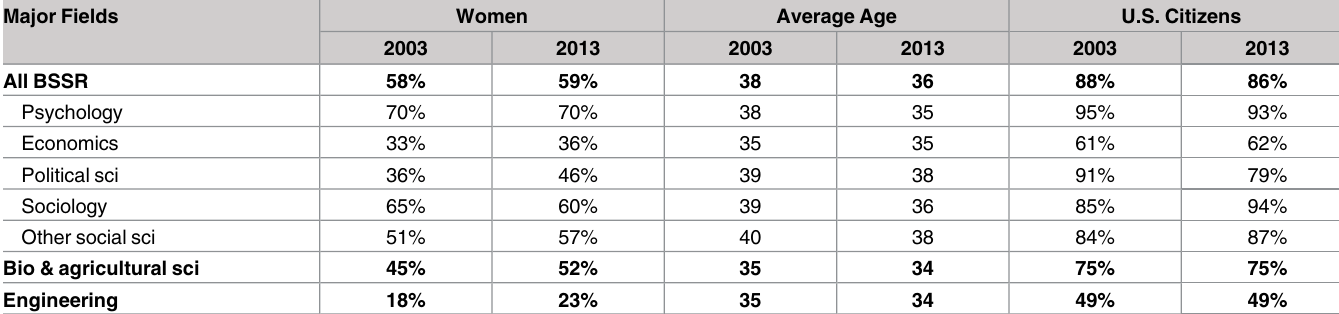
Table 3. Demographic trends of incoming PhDs in BSSR workforce by gender, age, and citizenship.